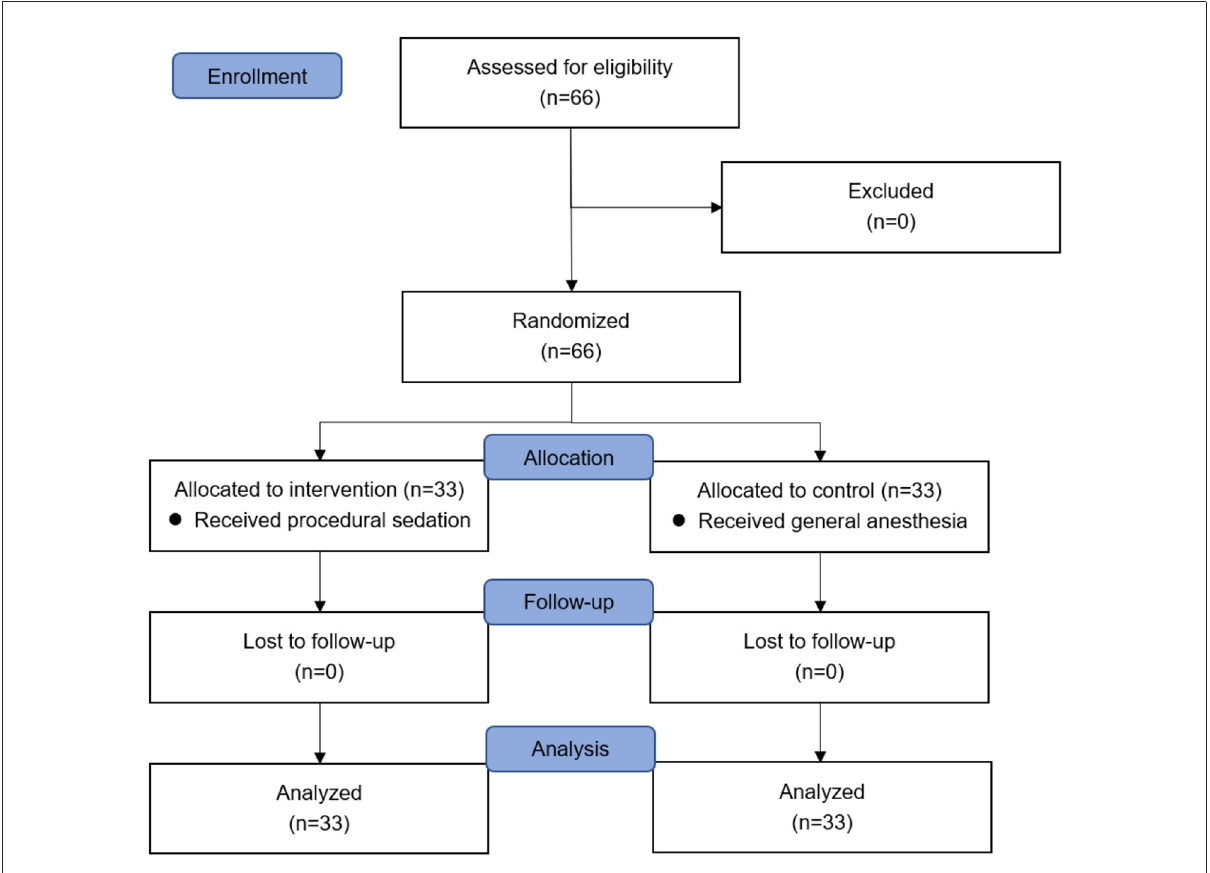
FIGURE1 CONSORT study flow